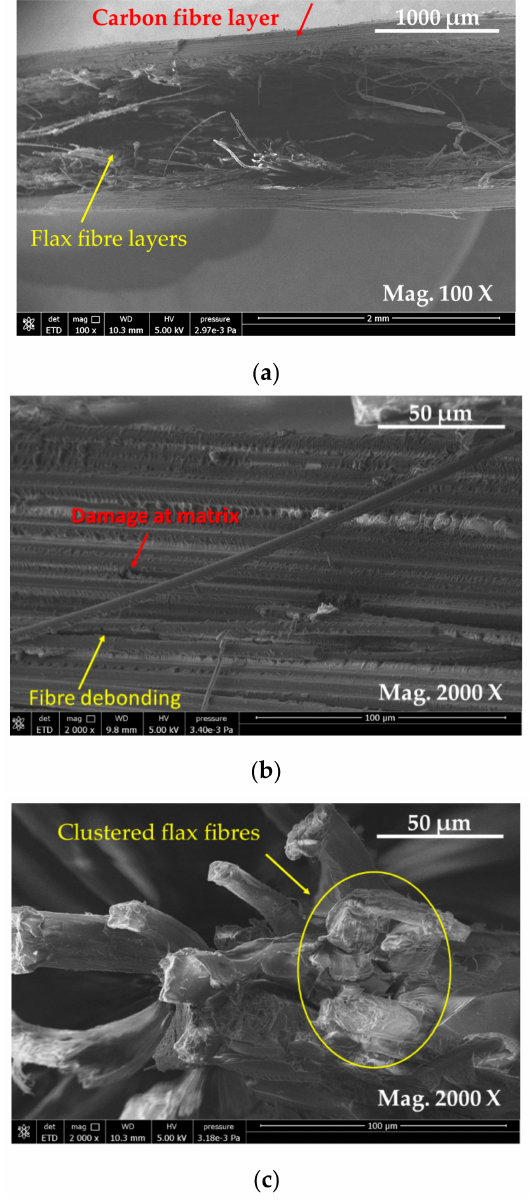
Figure 10. E-SEM micrographs of fractured surfaces of carbon flax hybrid composites: ( a ) image showing carbon fibre aligned on the top and bottom surfaces and flax being observed in the middle; ( b ) carbon fibre observed properly aligned, some defects on the surface of carbon fibre are visible and some delamination is also visible; and ( c ) flax fibres observed clustered in the